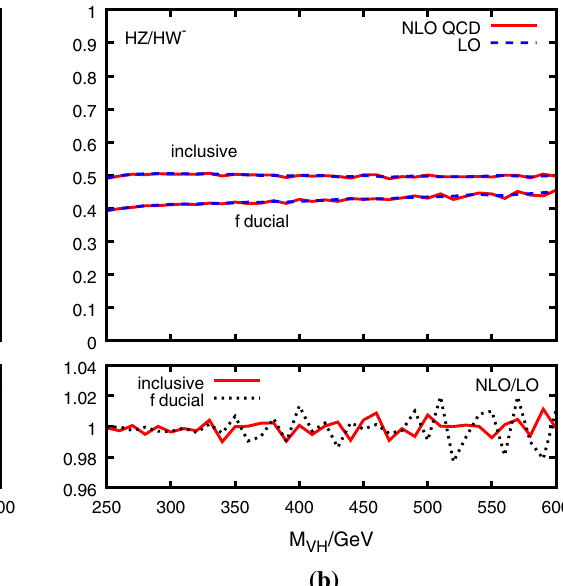
of the two. Obtained with HAWK [24,32] (only the decays Z → l + l − DY and W → l ν are included) using NNPDF23_qed_nlo PDFs with α ( M ) = 0 . 118[39] s Z